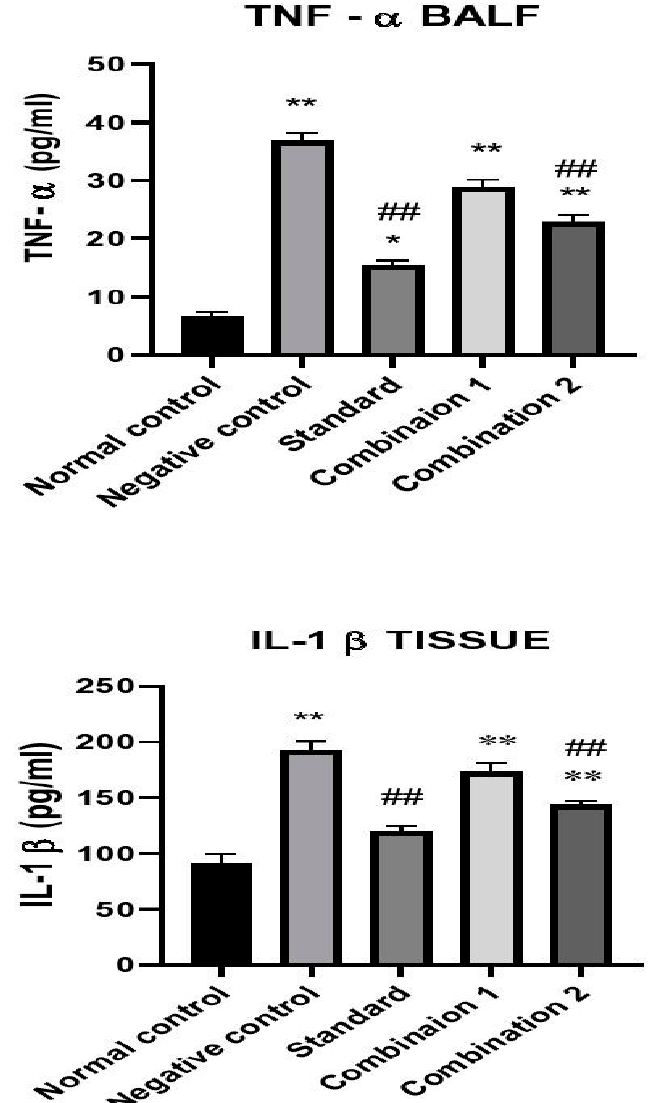
Figure 2. Effect of treatment combination on OVA-induced alteration in Cytokine analysis (IL-4, IL-13, TNF- α , IL-1 β ) of lung tissues and BALF. Data were analyzed by one-way ANOVA followed by Dunnett’s Multiple Comparisons Test. Values are expressed as Mean ± S.E.M. (n = 4). Statistical significance was assessed as * p < 0.05, ** p < 0.01 vs. normal control group and # p < 0.05, ## p < 0.01 vs. negative control group. Standard: 0.1 mg/kg dexamethasone + 0.5 mg/kg salbutamol, Combination 1: 30 mg/kg CSE + 0.5 mg/kg salbutamol, Combination 2: 60 mg/kg CSE + 0.5 mg/kg